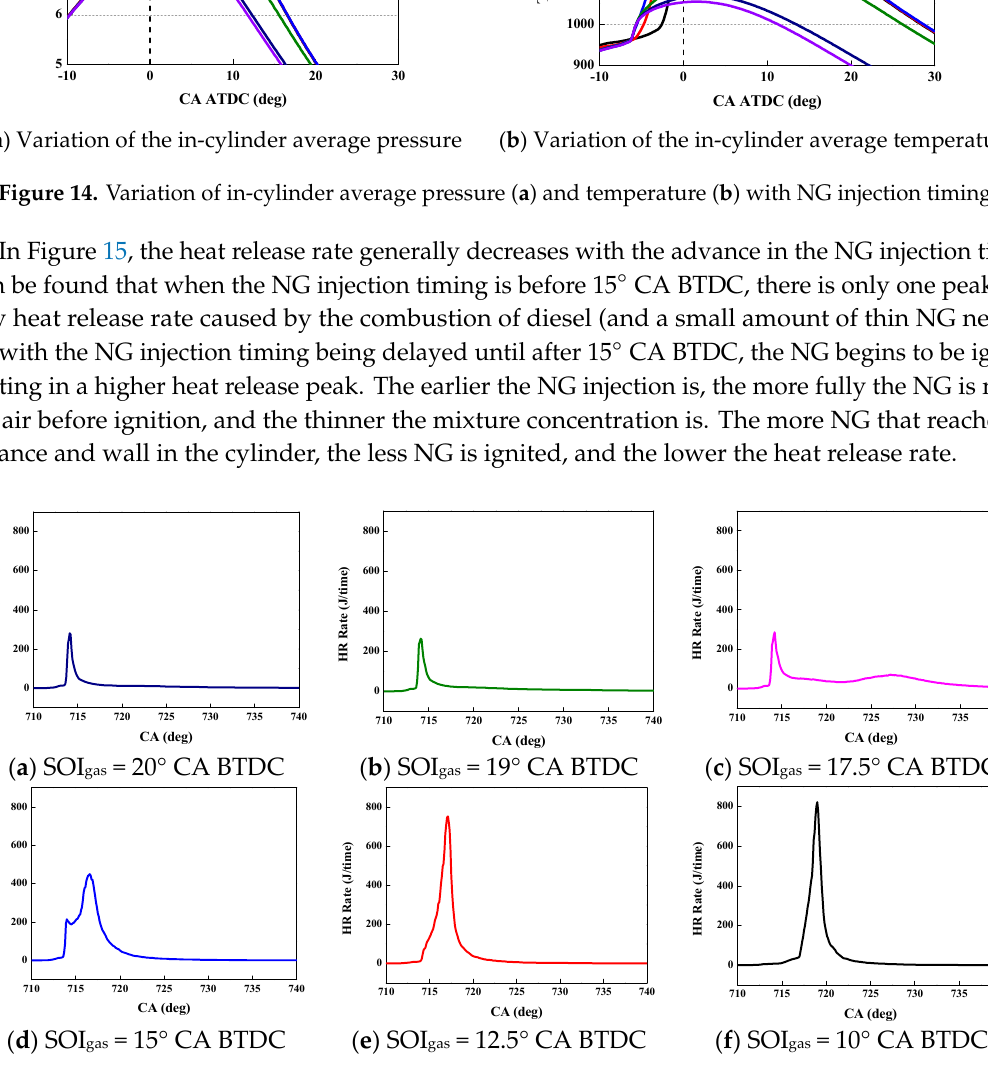
Figure 15. Variation of in-cylinder heat release rate with air injection timing.